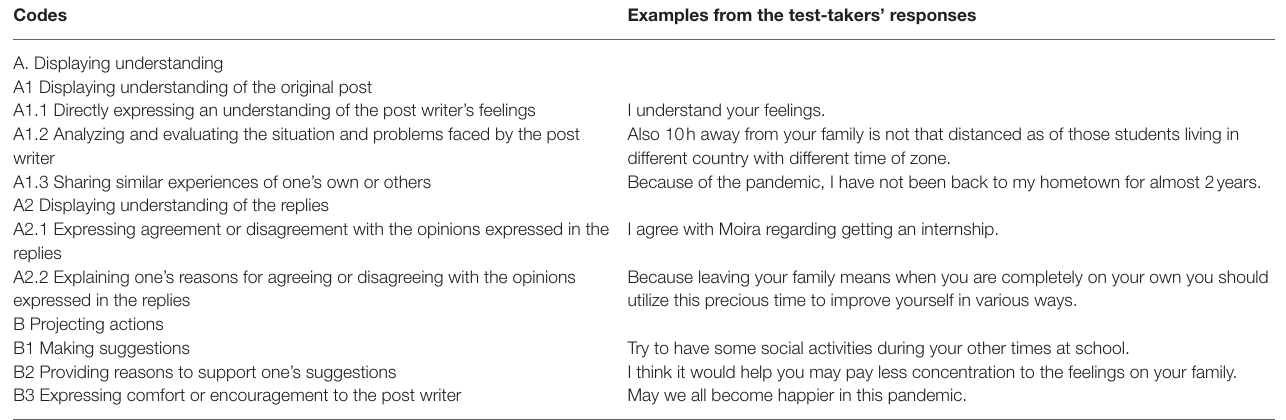
TABLE 2 | The coding scheme for interactional